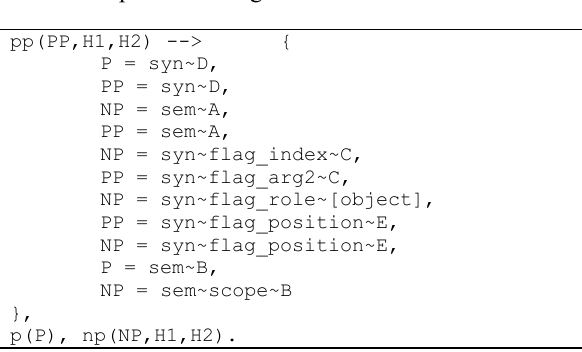
Figure 4. Analyse the Pphrase in first three group based on framework